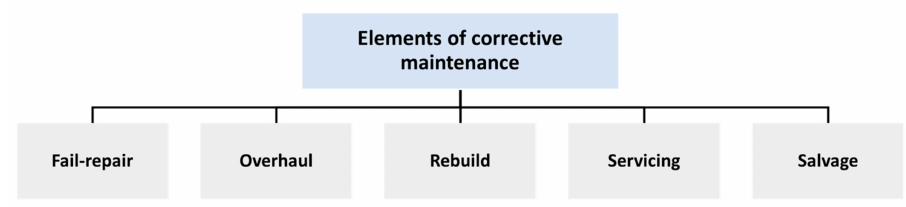
Figure 3. Elements of corrective